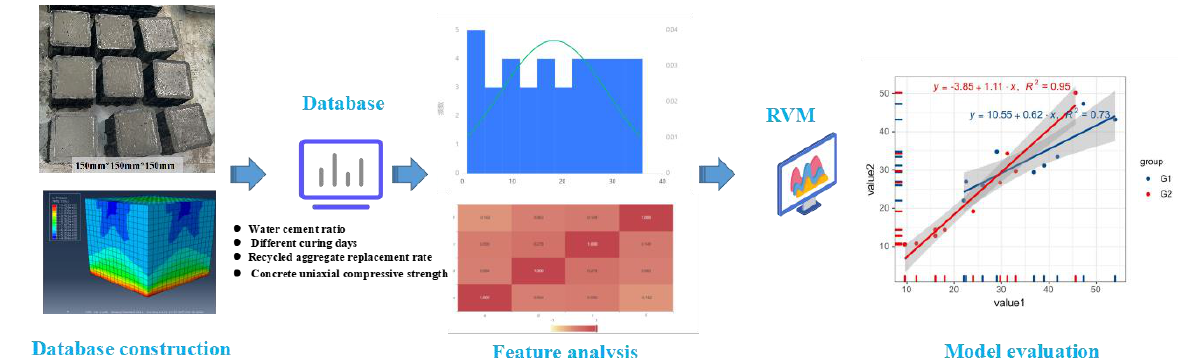
Figure 5. Regression prediction process of concrete strength based on RVM.